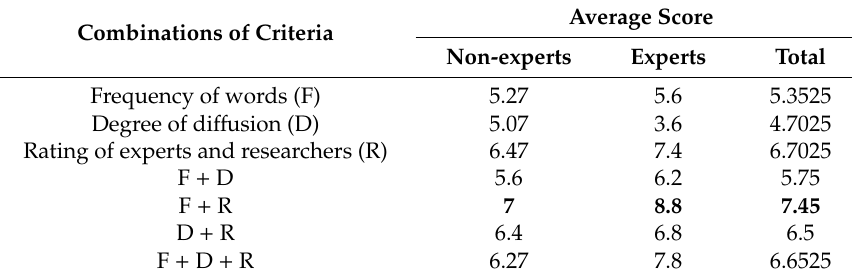
Table 6. Evaluation of criteria combinations for extracting